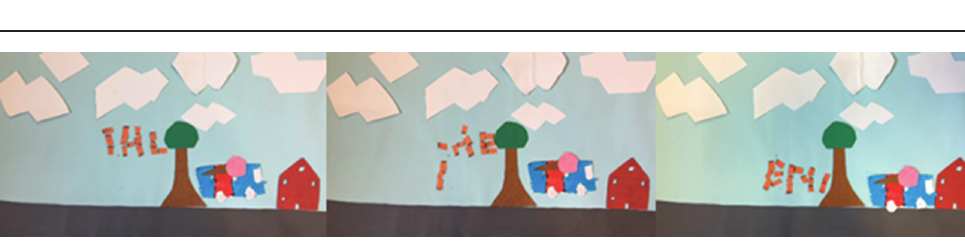
figure 2: ‘icy smoke’, Harrysmuir Primary, 2019 (source: